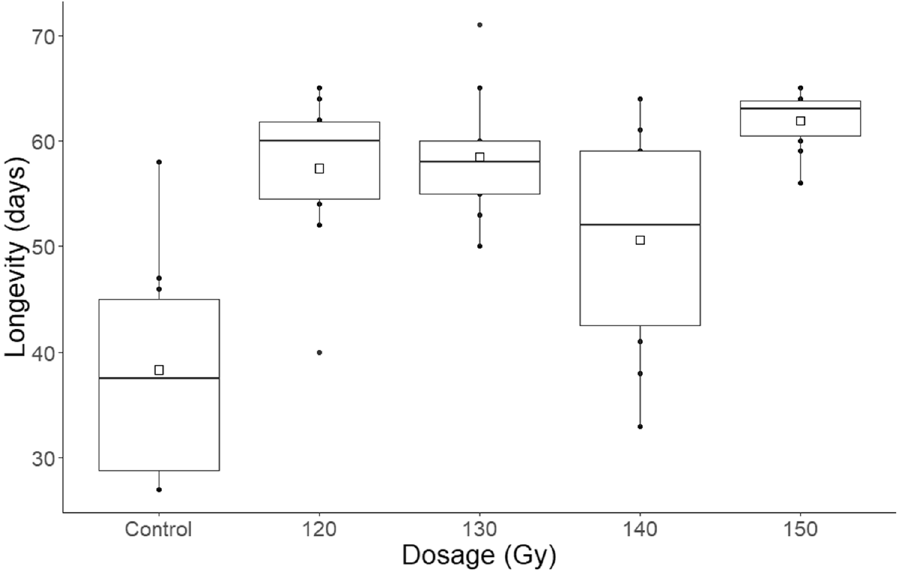
Figure 5. Boxplots of the longevity of irradiated and non-irradiated Trissolcus basalis . The box represents the interquartile range, and the whiskers are 1.5 times the interquartile range. Squares represent